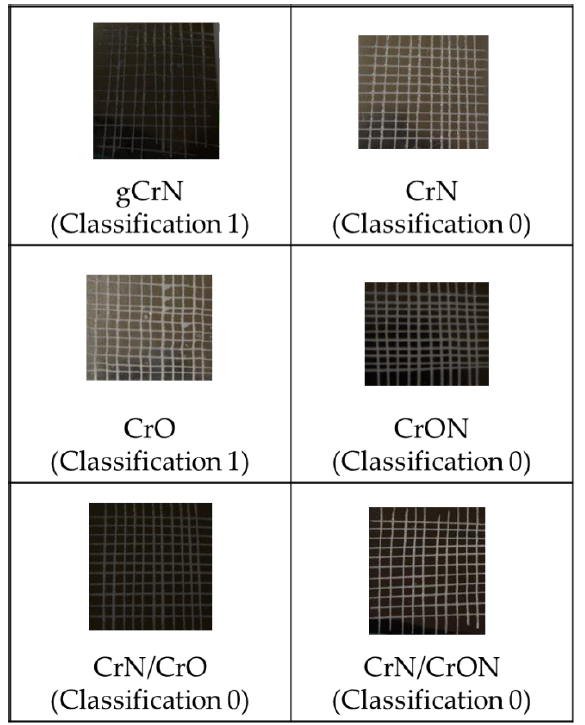
Figure 3. Adhesion behavior assessment of coatings deposited onto PC substrates.